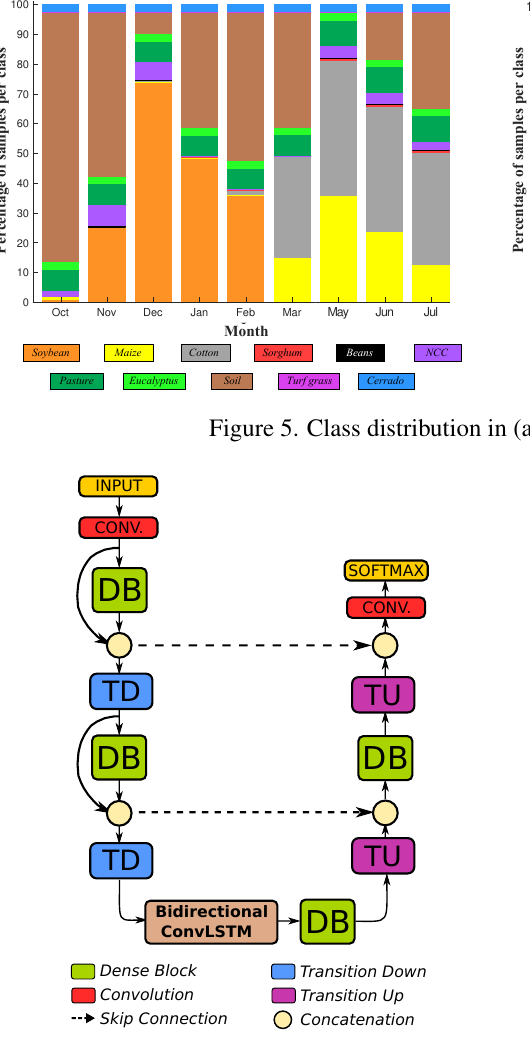
Figure 6. BDenseConvLSTM architecture.